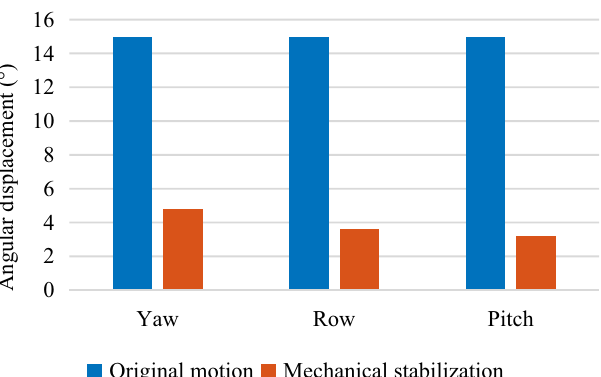
Figure 10. Motion amplitudes before and after motion compensation through mechanical stabilization in three rotating directions.